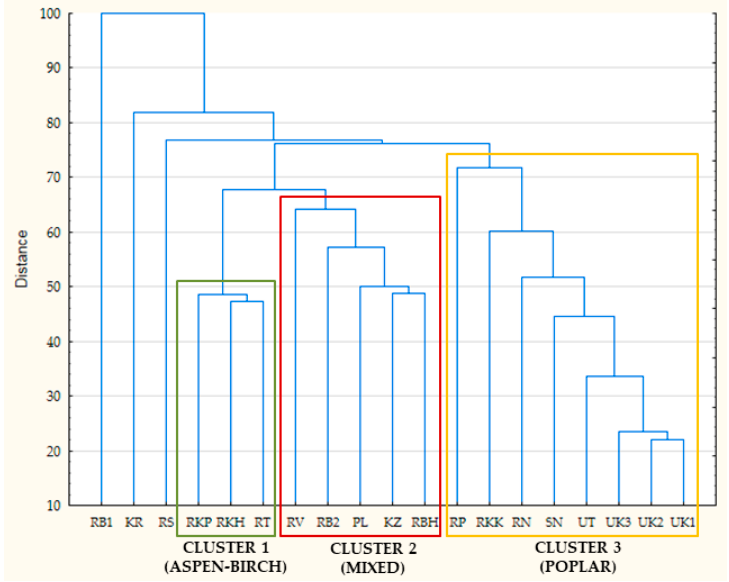
Figure 2. Classification of Eurasian propolis.